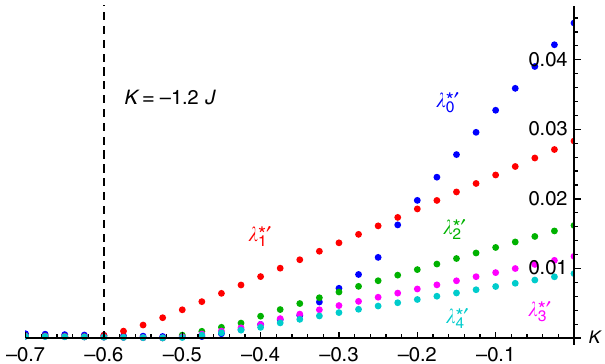
0.0 , of the Fig. 7 Spectrum. The real part of the most unstable eigenvalue, λ (cid:4) ′ m Fig. 8 Order parameter with disorder. Asymptotic behavior of order fi rst fi ve modes f = 0.5. Notice that they are m calculated from Eq. (15) for J parameter S = max( S + , S − ) vs. K for J = 0.5 and different amounts of all is positive for all K . Each λ (cid:4) ′ was calculated by approximating the integral m disorder as quanti fi ed by the width of the distribution of natural frequencies of the R.H.S. of (15) using Gaussian quadrature with N ′ = 200 grid σ and the noise strengths, D θ , D x , and D y . As can be seen, greater amount of points and diagonalizing the resulting matrix. The upper limit of integration disorder stabilize the async state, as indicated by − K c becoming smaller and R = 1.15 was measured from simulations. The radial density g ( r ) was smaller. Note also the disappearance of the dip in the S ( K ) curve, which determined numerically as discussed in Supplementary Note 1. The kernels tells us the splintered phase wave state does not exist in the presence of H m in Eq. (15) for m > 1 were calculated numerically. The dashed line marks noise of this strength. Simulations were run for N = 500 swarmalators the approximation to the critical coupling strength (18) using Heun ’ s method for T = 1000 time units with stepsize dt = 0.01, the fi rst half of which were discarded. Each data point represents the average of 10 In Fig. 7 we plot λ (cid:4) ′ N ′ ð Þ vs. K for J = 0.5 and N ′ = 200 grid points. 0 As can be seen it is small but positive for suf fi ciently negative K . (cid:5) (cid:2) 0 : 5 Note however that there is a transition-like point K (cid:4) 0 N ′ ð Þ increases sharply. Figure 7 also shows beyond which λ (cid:4) ′ 0 λ (cid:4) ′ N ′ ð Þ for m = 1, 2, 3, 4, which have the same behavior as m λ (cid:4) ′ N ′ ð Þ : they are small but positive for K < K (cid:4) , and grow sharply m 0 . for K > K (cid:4) m